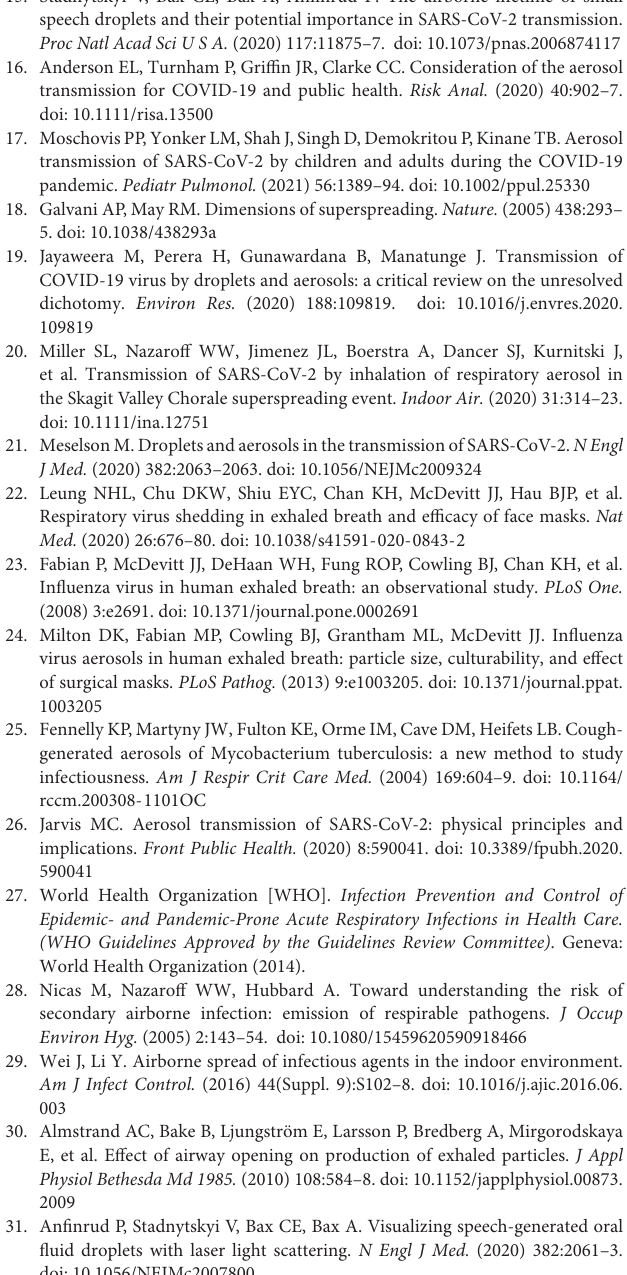
Supplementary Figure 1 | Aerosol Resp-Aer-Meter (A) structure and (B) function. Supplementary Figure 2 | Sample measurement of